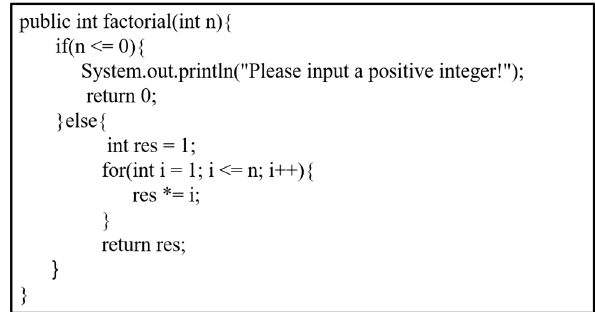
Figure 2. Factorial function of the positive integer n.